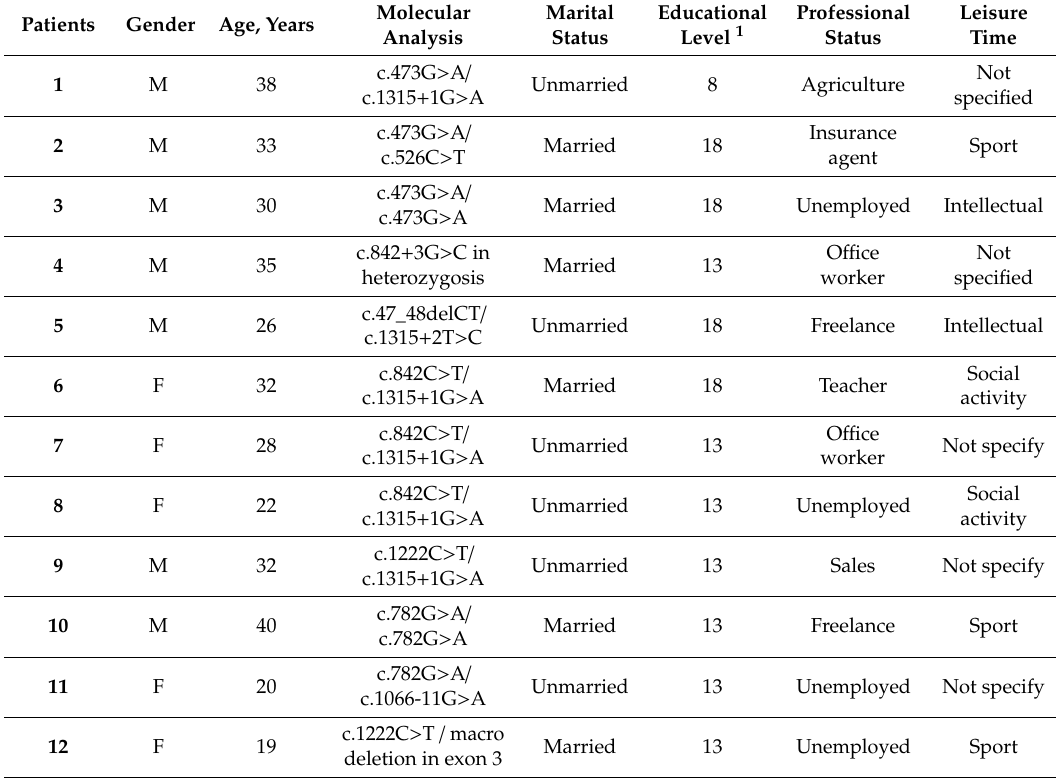
Table 1. Demographic characteristics of the cohort of adult phenylketonuria (PKU) patients (n = 12).